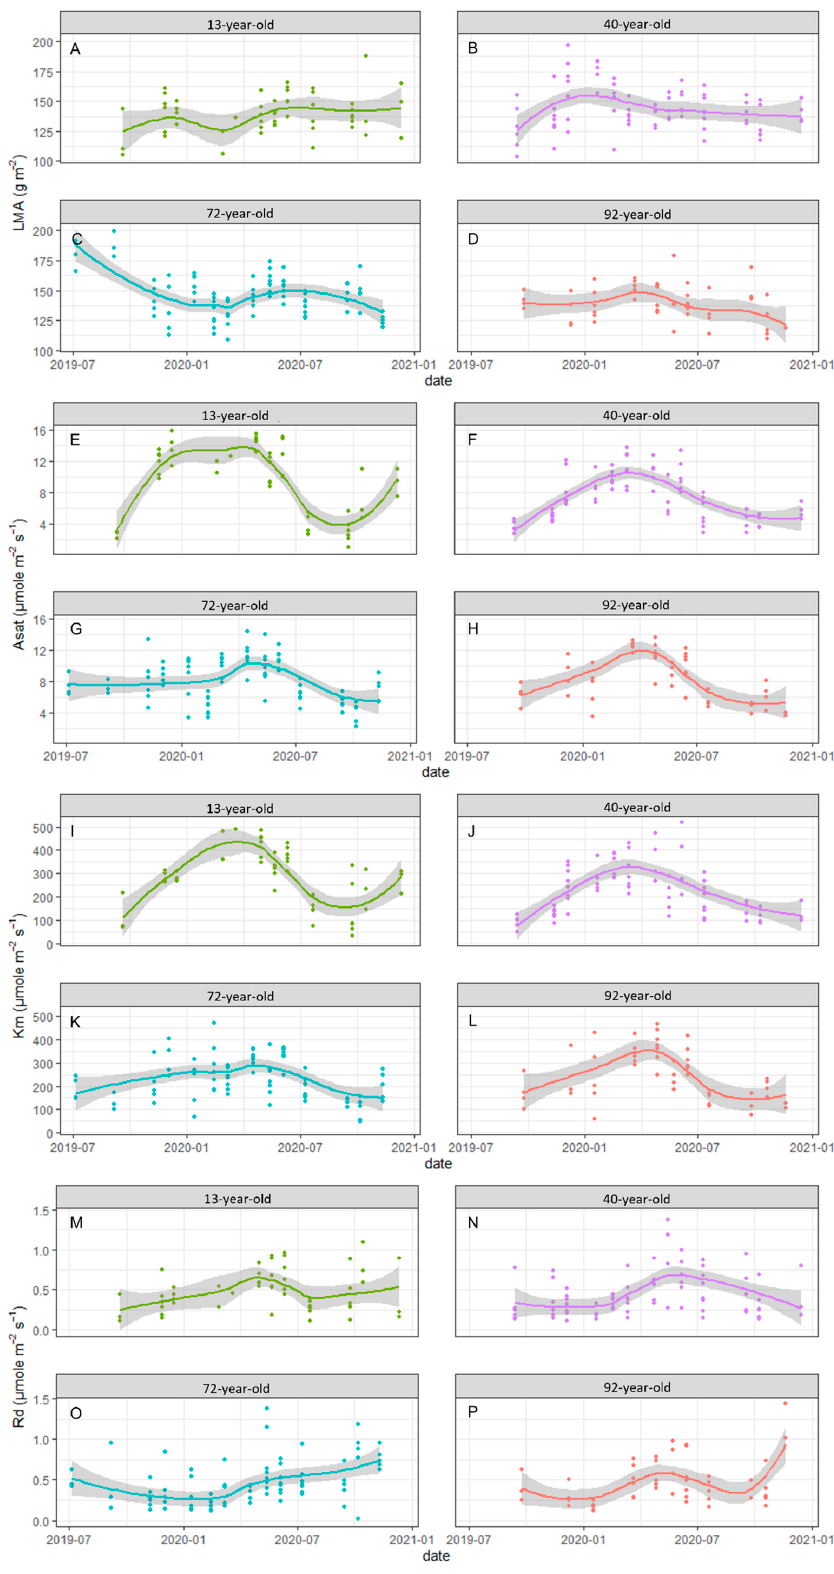
Figure 2. Seasonal variation of Leaf Mass per Area (LMA, ( A – D )), saturated net photosynthetic rate ( A sat , ( E – H )), half saturation coefficient ( K m , ( I – L )) and dark respiration rate ( R d , ( M – P )) across all study plots. Curves are locally weighted scatterplot smoothing regression analyses with a 95% confidence interval (shaded area) and dots are the individual